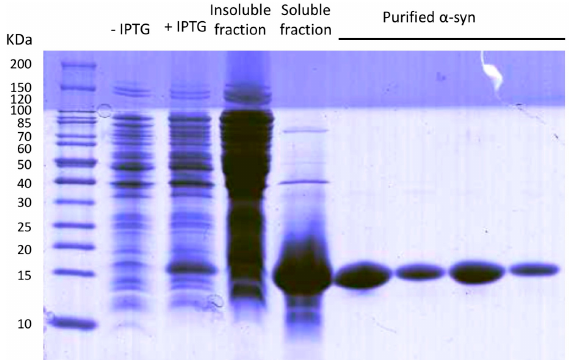
Figure 2. SDS-PAGE of the expression, fractionation and purification process. − IPTG and +IPTG (isopropyl β - D -1-thiogalactopyranoside) lines correspond to-non induced and induced cell extracts. The insoluble and soluble fractions of induced cells are shown as well as different fractions eluting from the anion exchange column.